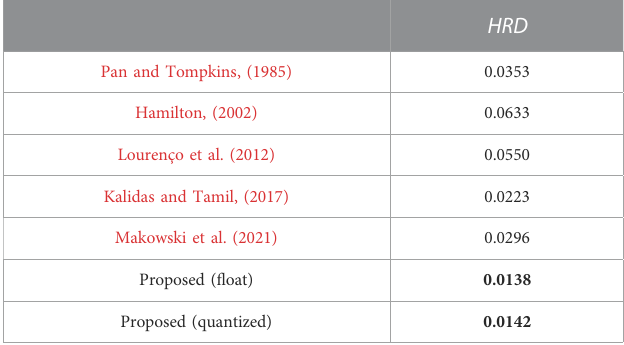
TABLE 2 Heart rate estimation performance comparison.